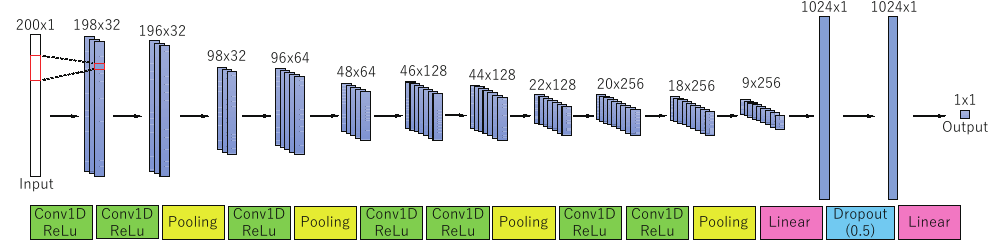
Figure 1. Flow of the EMG estimation method.